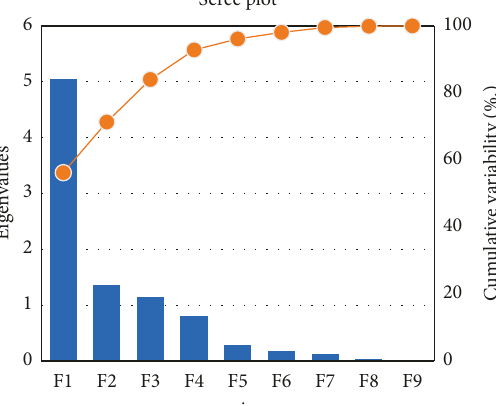
Figure 4: Eigenvalue distribution on the axes. Scree plot